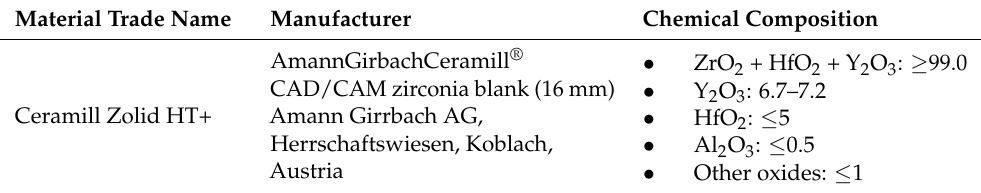
Table 1. Commercial name and detail of the material used in the